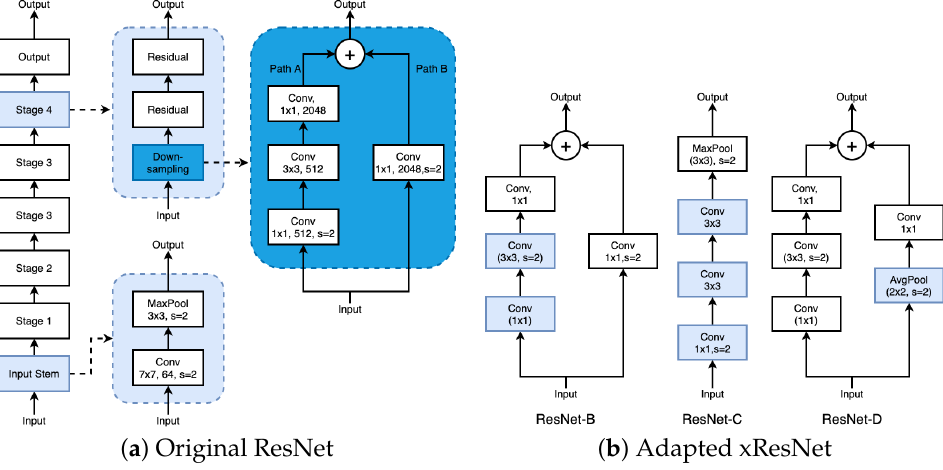
Figure 3. The original ResNet architecture ( a ) and the adapted xResNet architecture ( b